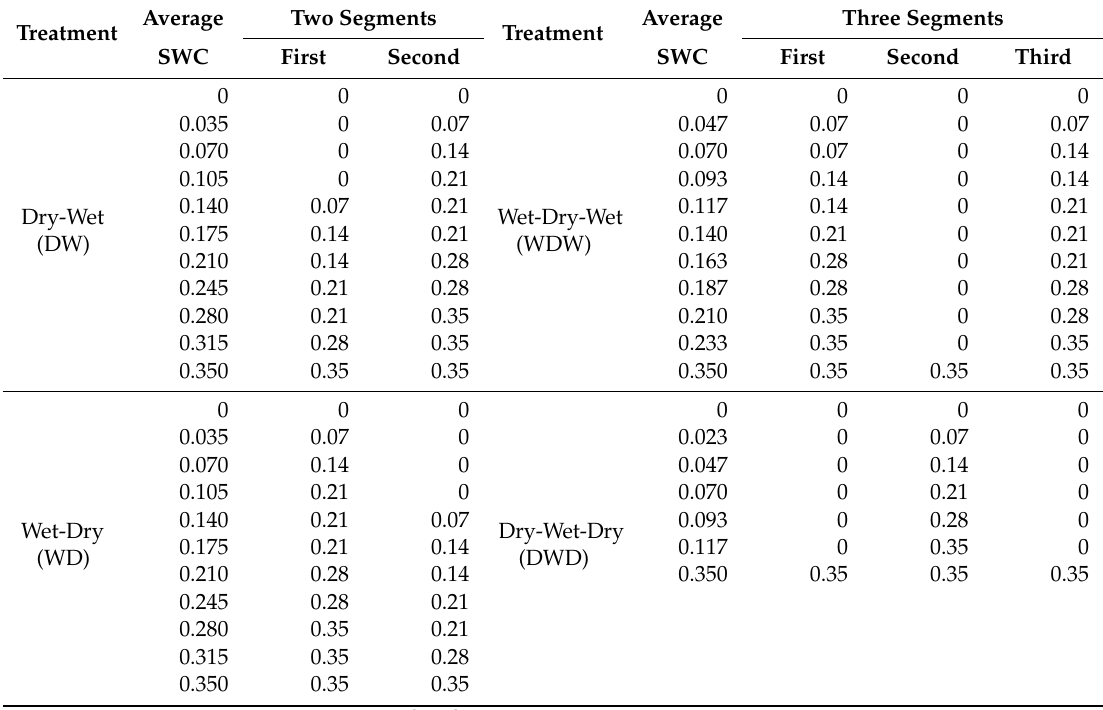
Table 2. Water content in the soil container divided into di ff erent